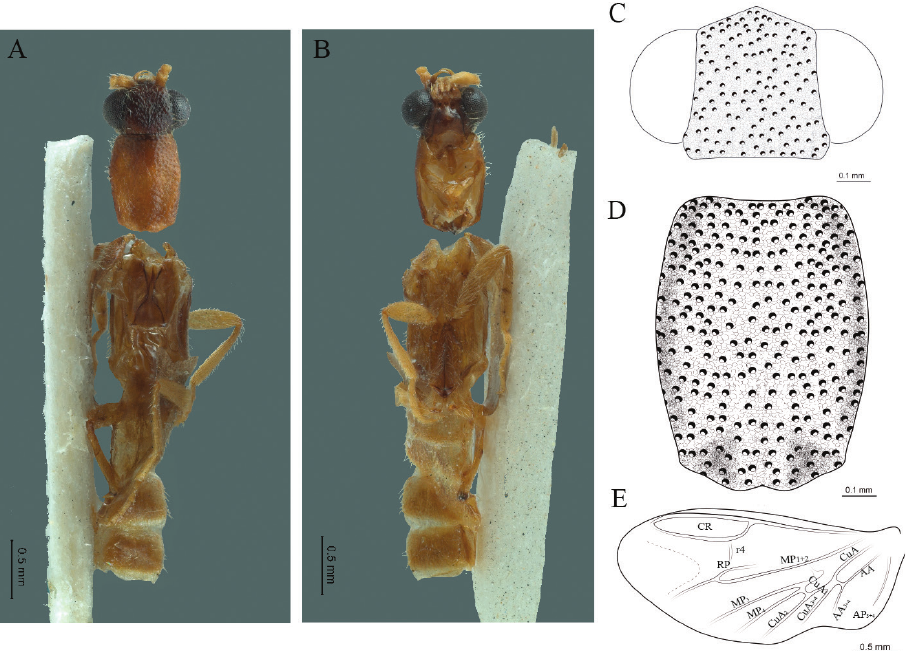
Figure 27. Cenophengus sonoraensis Zaragoza-Caballero, 2008, male. Habitus: A dorsal B ventral C head dorsal D pronotum dorsal E hind wing. Wing venation: CR = Radial Cell; r4 = radial 4 vein; RP = Posterior Radial vein; MP1+2 = Posterior Median vein; CuA = Cubital vein; AA and AP = Anterior and Posterior Anal